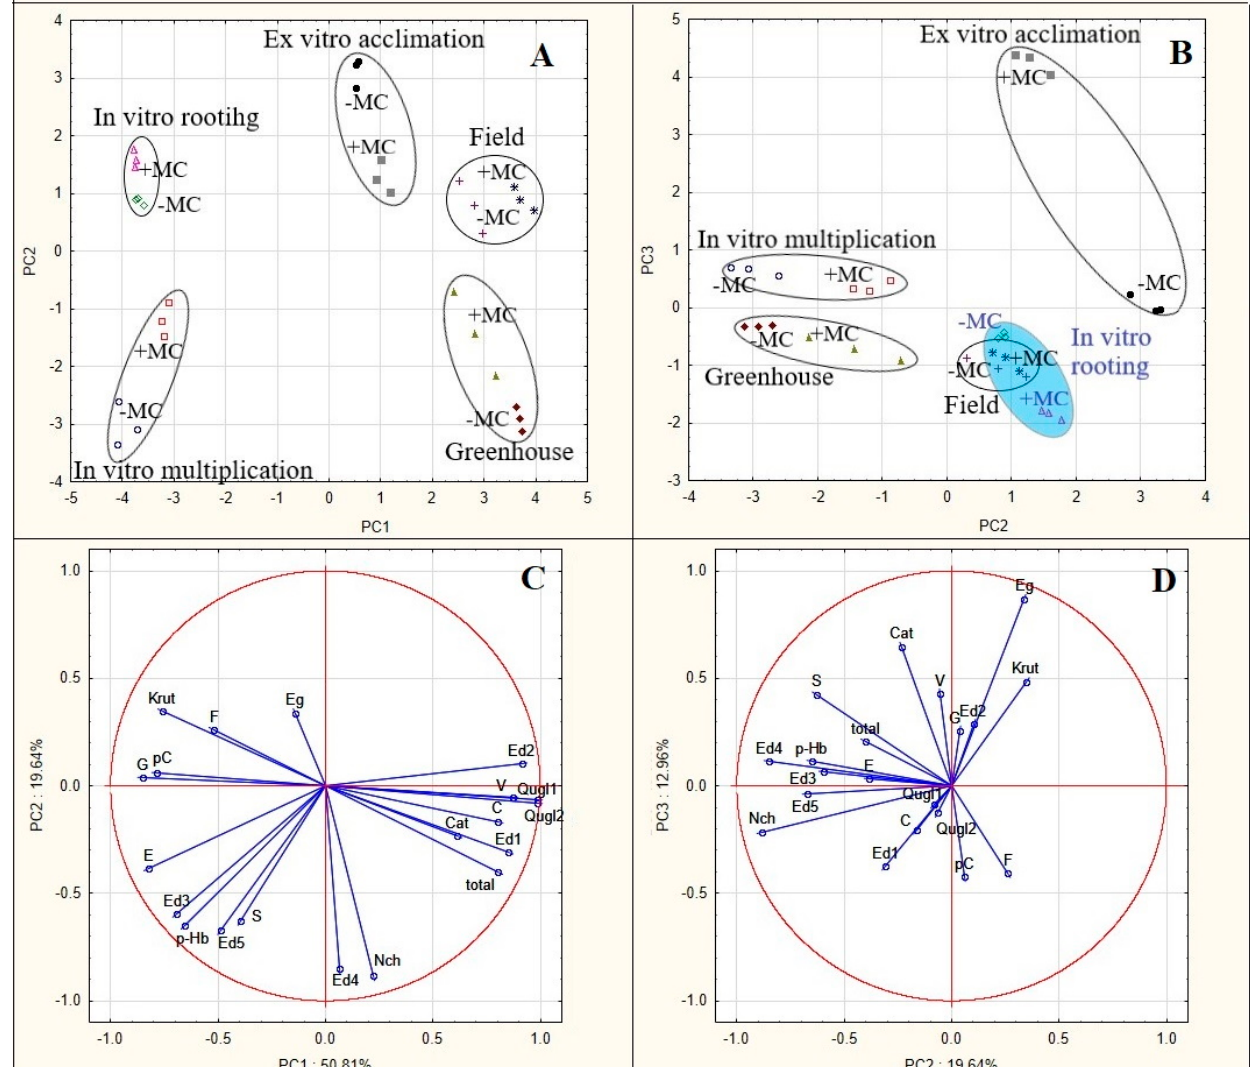
Figure 7. PCA score plots of PC1 versus PC2 ( A ) and PC2 versus PC3 ( B ) from PCA of a 20-variable matrix for the five different propagation stages without ( − MC) and with mechanocomposite (+MC) treatment of strawberry cv. ‘Solnechnaya polyanka’ plants. Projections of the variables on the factor plane of PCA of the 20 parameters of the phenolic profile of the plants: ( C ) loading plots for the compounds’ variables contributing to PC1 and PC2; ( D ) loading plots for the compounds’ variables contributing to PC2 and PC3. Abbreviations: MC, mechanocomposite; − MC, mechanocomposite free; +MC, mechanocomposite treatment; G, gallic acid; Nch, neochlorogenic acid; Cat, (+)-catechin; p -Hb, p -hydroxybenzoic acid; Eg, epigallocatechin gallate; Ed 1–5, ellagic acid derivatives 1–5; C, caffeic acid; V, vanillic acid; S, syringic acid; p C, p -coumaric acid; F, ferulic acid; Qugl 1 and 2, quer- cetin glycosides 1 and 2; E, ellagic acid; Krut, kaempferol rutinoside; and Total, total phenolic con- tent.